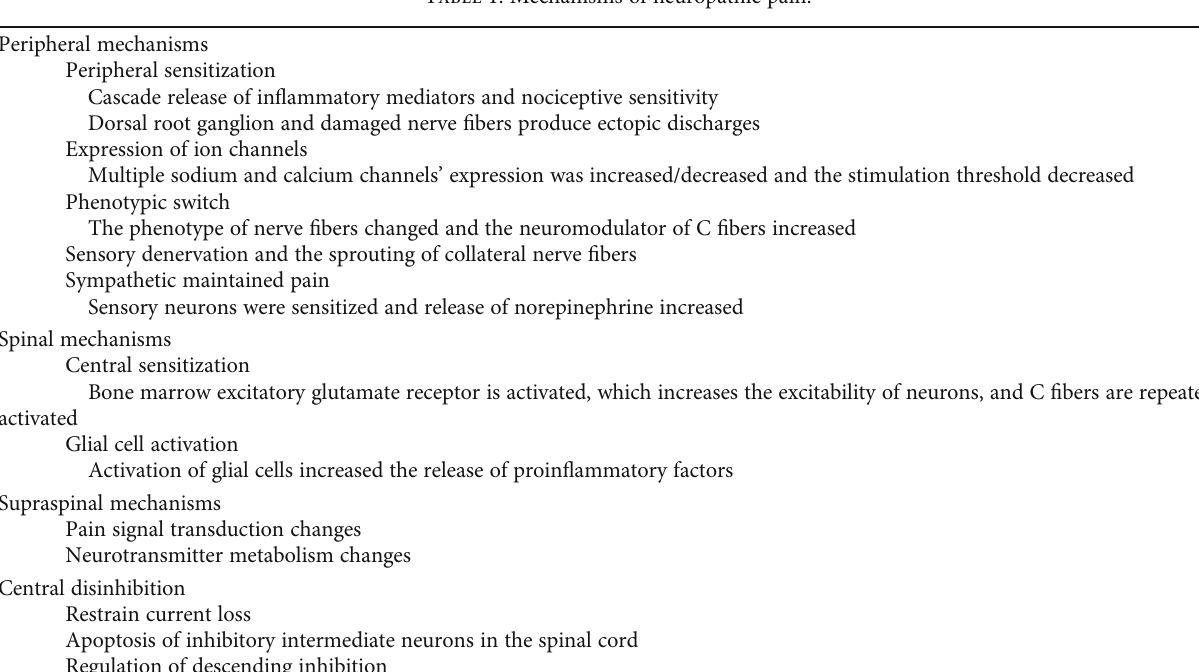
Table 1: Mechanisms of neuropathic